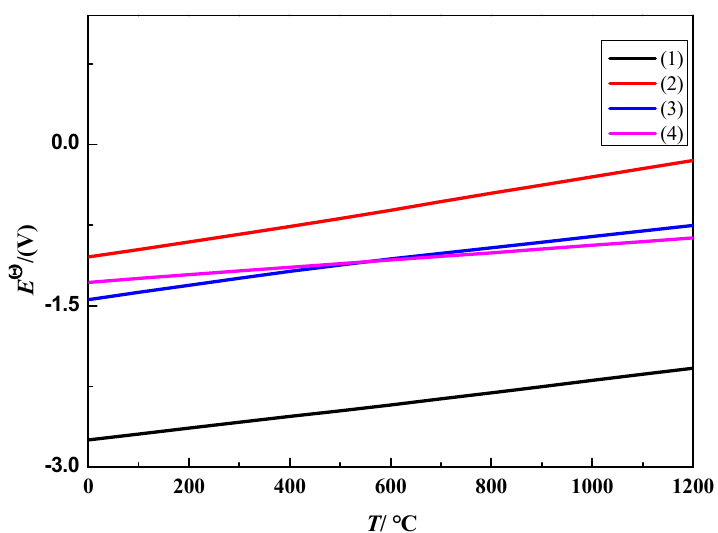
Figure 2. E Θ – T diagram of electrochemical reactions that may occur in the process of elec- tro-deoxidation.